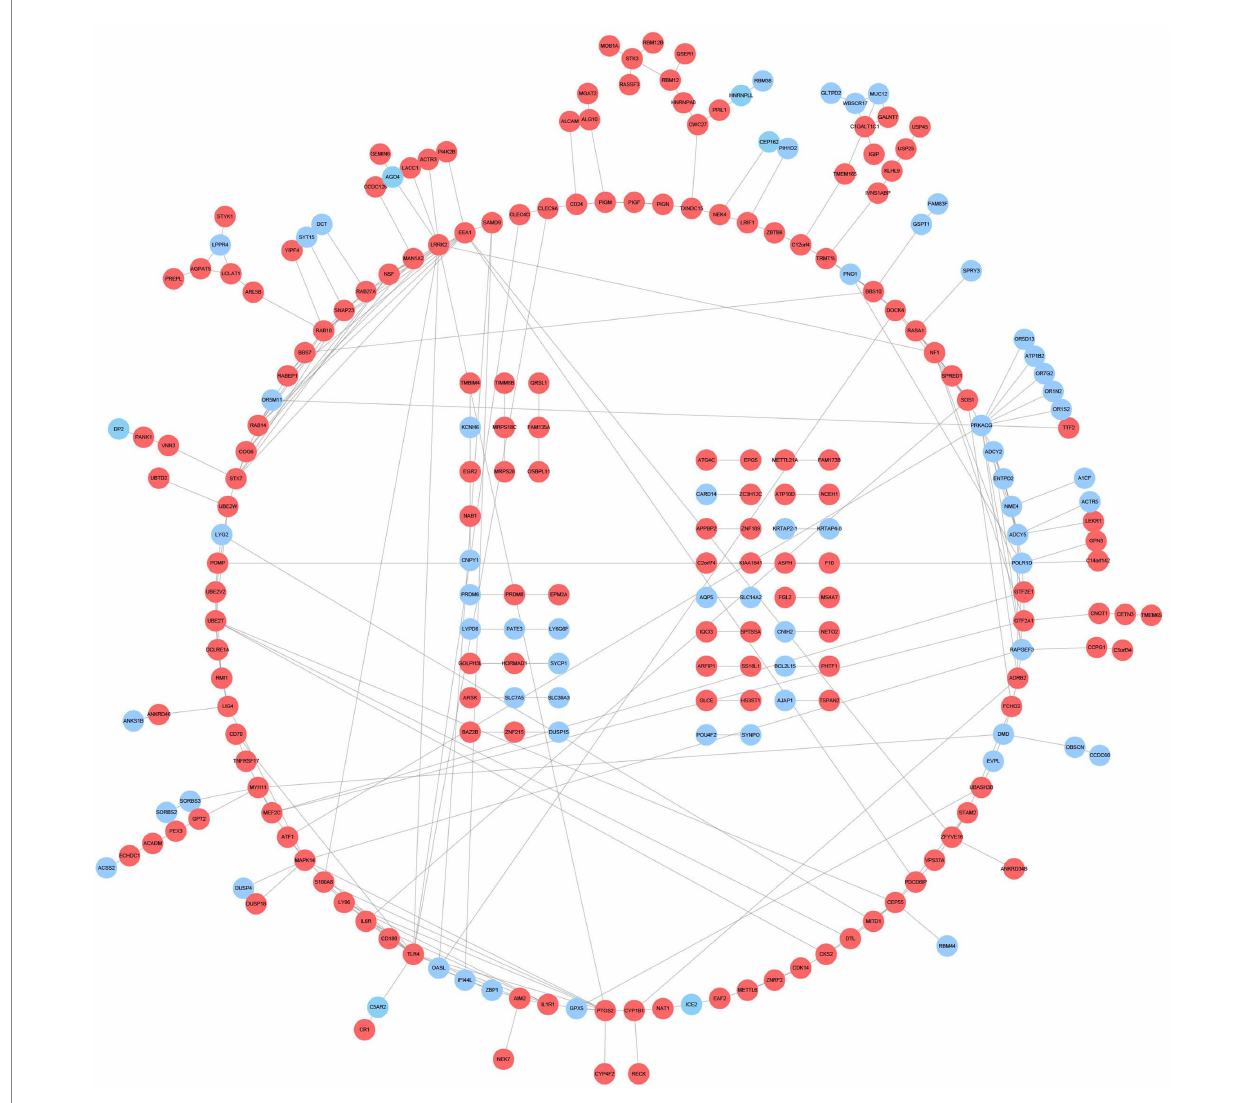
FIGURE 5 PPI network and common DEGs. Red indicates upregulated genes, and blue-violet indicates down-regulated